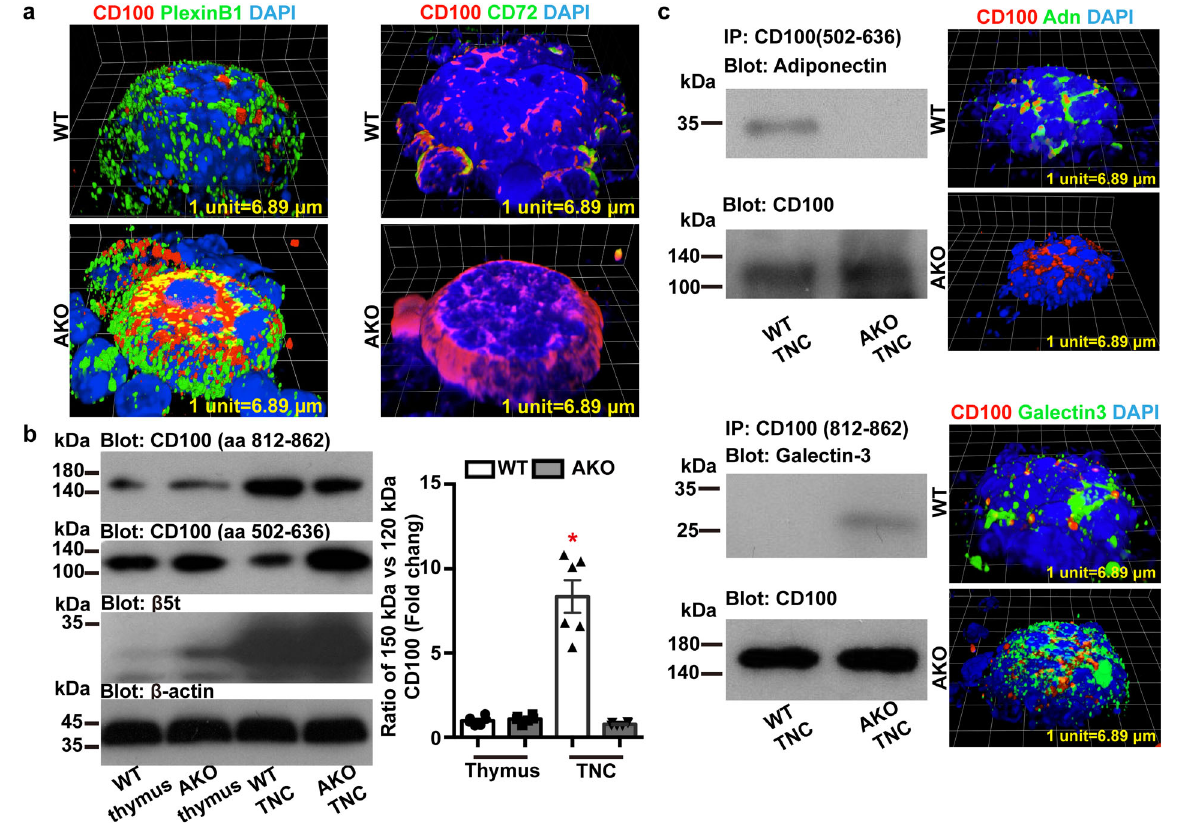
Fig. 9 Adiponectin regulates the expression and distribution of CD100 within the TNC complexes. WT or AKO mice were sacri fi ced at the age of 7 weeks to collect the thymus for subsequent analyses. a TNC complexes were prepared for immuno fl uorescence staining with antibodies against CD100 [Cat No. 565556 from BD Biosciences ( left ) or Cat No. Ab231961 from Abcam ( right )], plexin B1 or CD72. Confocal microscopic analyses revealed different patterns of CD100 protein distribution in relation to plexin B1 or CD72 in the TNC complexes from WT and AKO mice, respectively. b Western blotting was performed to analyze the protein expression of CD100 in thymus and TNC lysates prepared from WT and AKO mice, using antibodies recognizing different regions [from amino acid 812 – 862 or 502 – 636] of this molecule. Beta-actin [ β -actin] was detected as the loading controls and β 5t probed as a marker for TNC complexes. c TNC complexes were prepared for co-immunoprecipitation using antibodies recognizing CD100 from amino acid 502 – 636 ( top ) or amino acid 812 – 862 ( bottom ). The presence of adiponectin or galectin-3 in the immune complexes was con fi rmed by Western blotting using speci fi c antibodies ( left ). Immuno fl uorescence staining and confocal microscopic analyses were performed to analyze the interactions between CD100 and adiponectin or galectin-3 within the TNC complexes ( right ). Data were presented as mean ± SEM. *, P < 0.05 vs WT thymus ( n = 6 biologically independent samples from different animals of independent